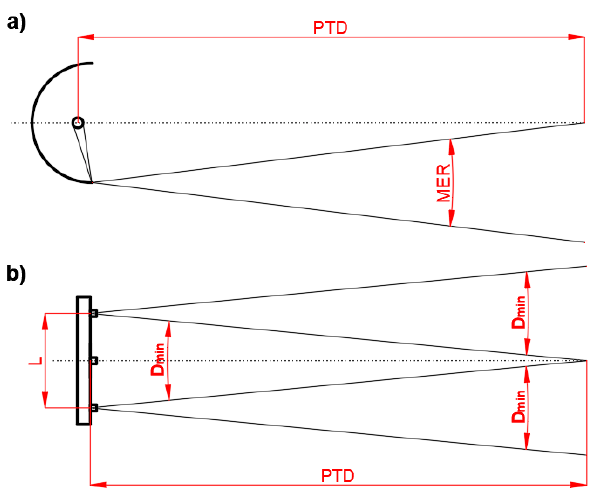
Figure 6. Graphical definition of the photometric test distance (PTD ) for: ( a ) the conventional luminaires and ( b ) the multi-source LED luminaires; MER—the minimal elementary reflection, D min —the minimal divergence, L —the maximum distance between diodes.